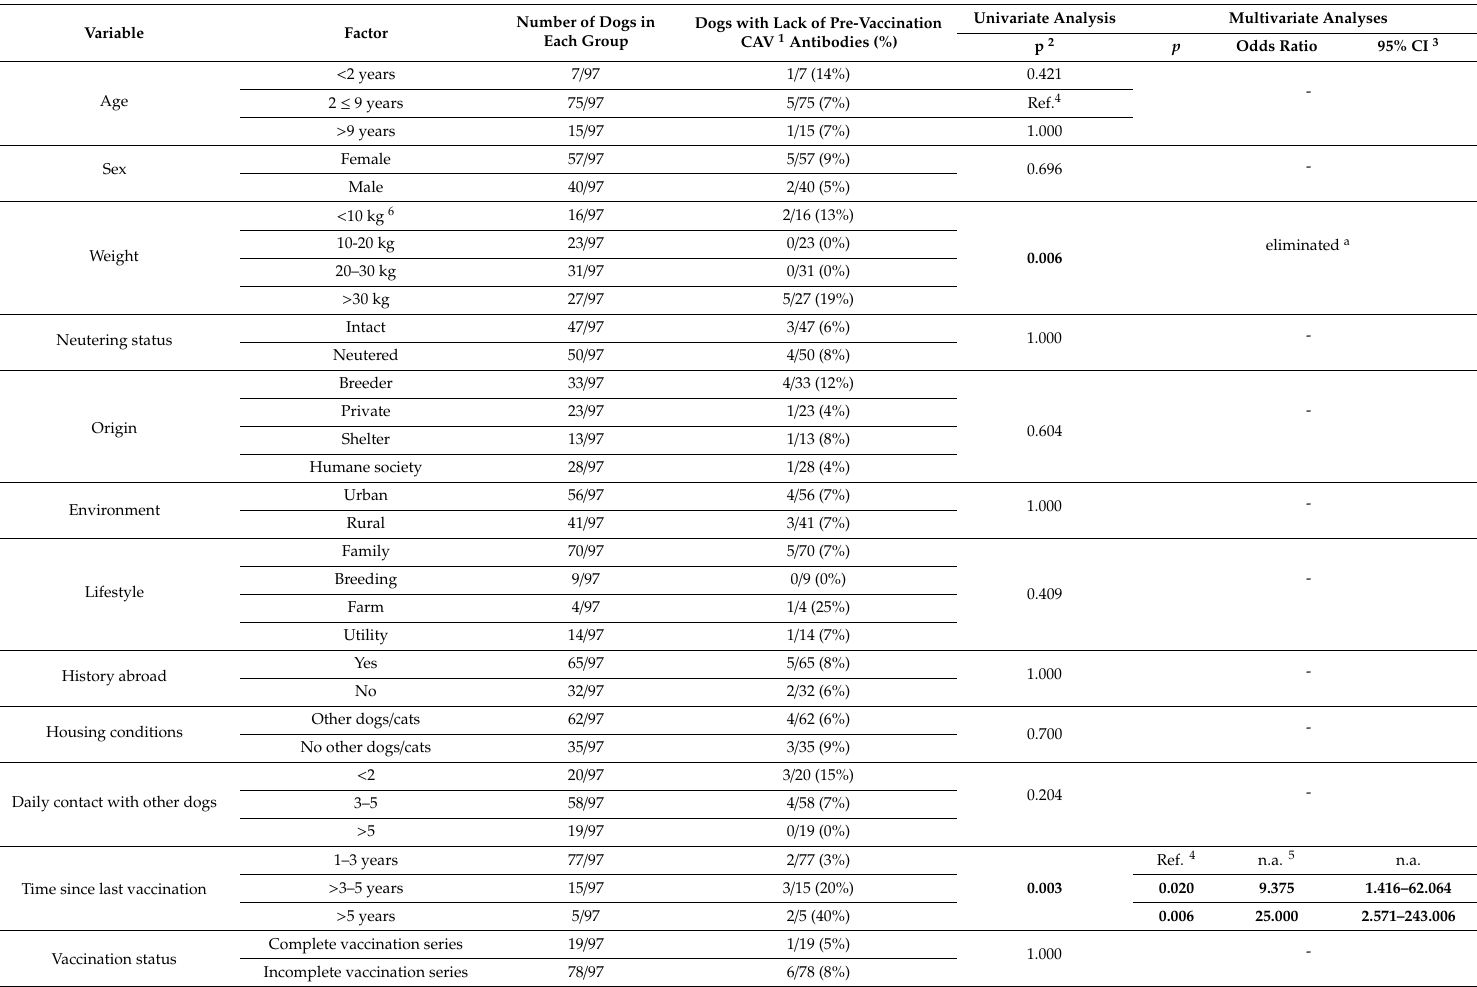
Table 1. Factors associated with lack of antibodies against canine adenovirus in univariate and multivariate